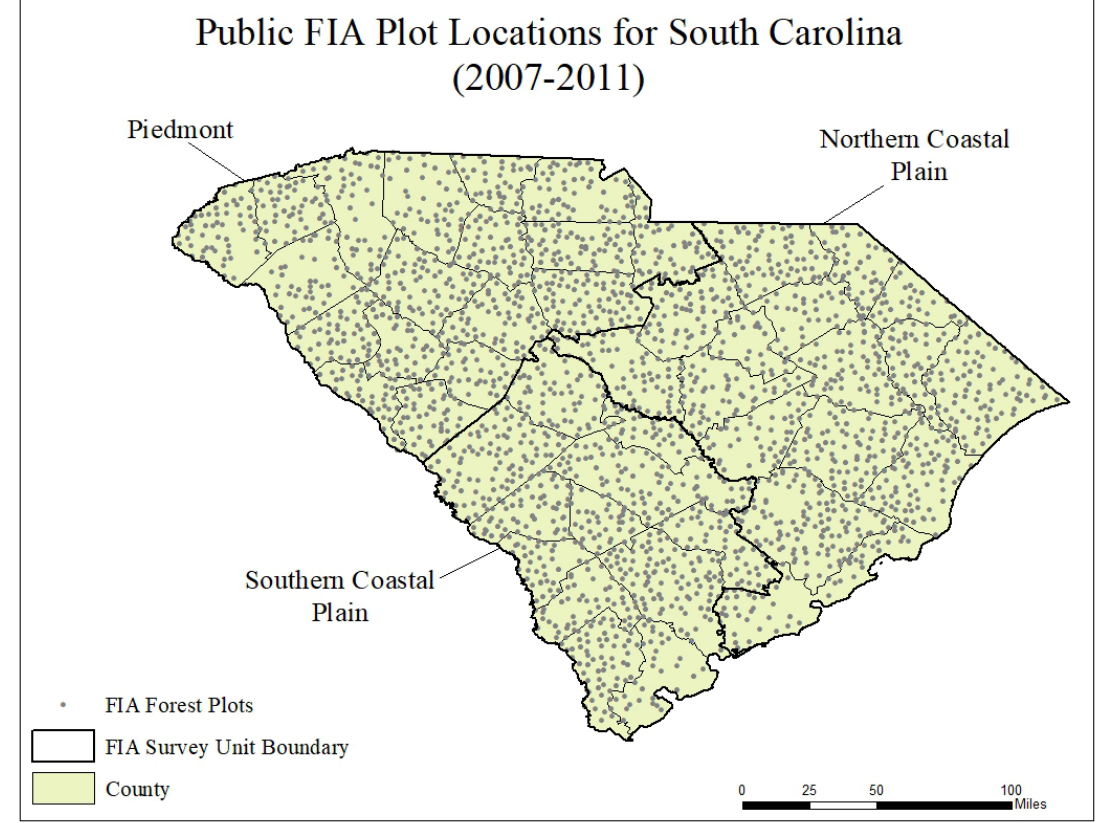
Figure 1. FIA plot locations and boundaries of counties and survey units. (Plot locations have been jittered to protect privacy.) South Carolina has three survey units. In 2011, the smallest survey unit in South Carolina contained 672 surveyed plots with some forest use, whereas the smallest county contained only 25 such